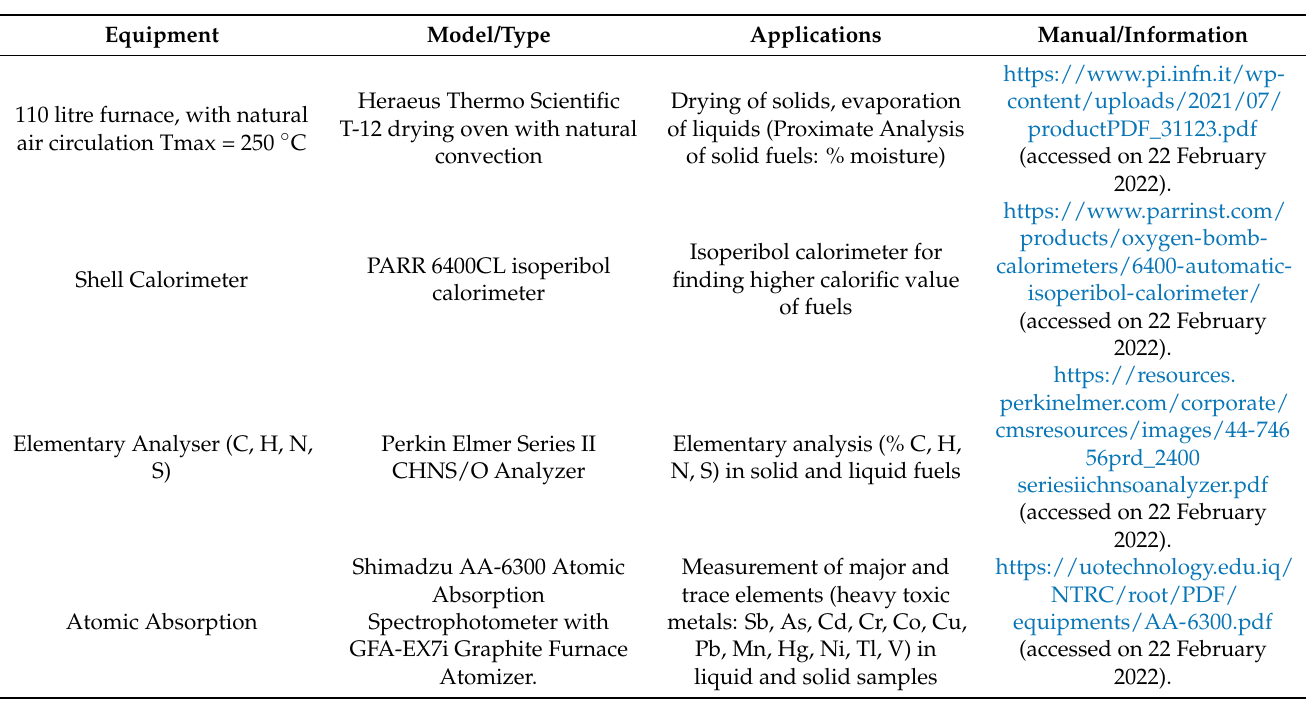
Table A1. Information about lab